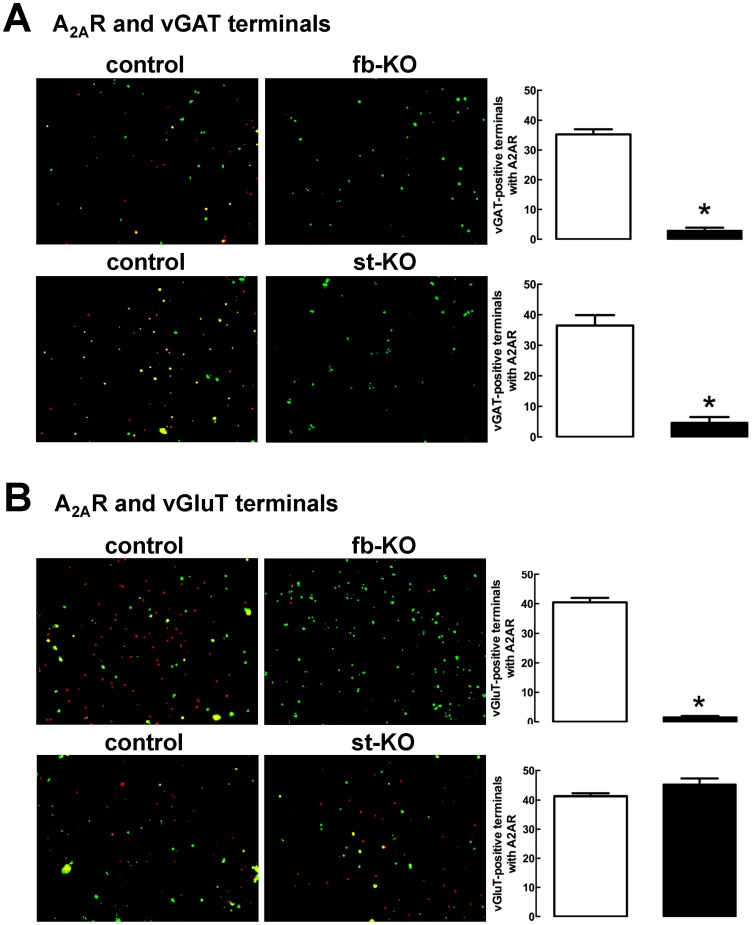
Deletion of A2AR immunoreactivity in glutamatergic terminals of forebrain-A2AR KO and GABAergic terminals of both forebrain A2AR - and striatum-A2AR KO mice.Detection and quantification of the percentage of GABAergic terminals (A, vGAT-positive) and glutamatergic terminals (B, vGluT1-positive) and from forebrain-selective-A2AR KO (fb-KO) or striatum-selective-A2AR KO (st-KO) mice and their wild type (WT) littermates (control) that are endowed with A2AR immunoreactivity. The bar graphs represent the percentage of vGluT1- or vGAT-immunopositive terminals that are also endowed with A2AR immunoreactivity (mean ± SEM, 3 fields per mouse, n = 4-6 animal per group). * p<0.05 vs corresponding WT littermates, using an unpaired Student’s t test. On the left side of each bar graph are shown representative immunocytochemistry photographs displaying the superimposed immunoreactivities of vGluT1 or vGAT (green) and of A2AR (red).